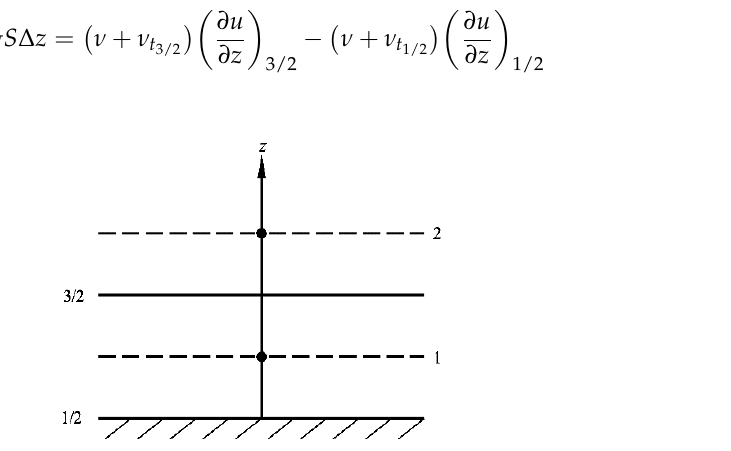
Figure 4. Grid discretization for the near-bed layer ( i = 1).